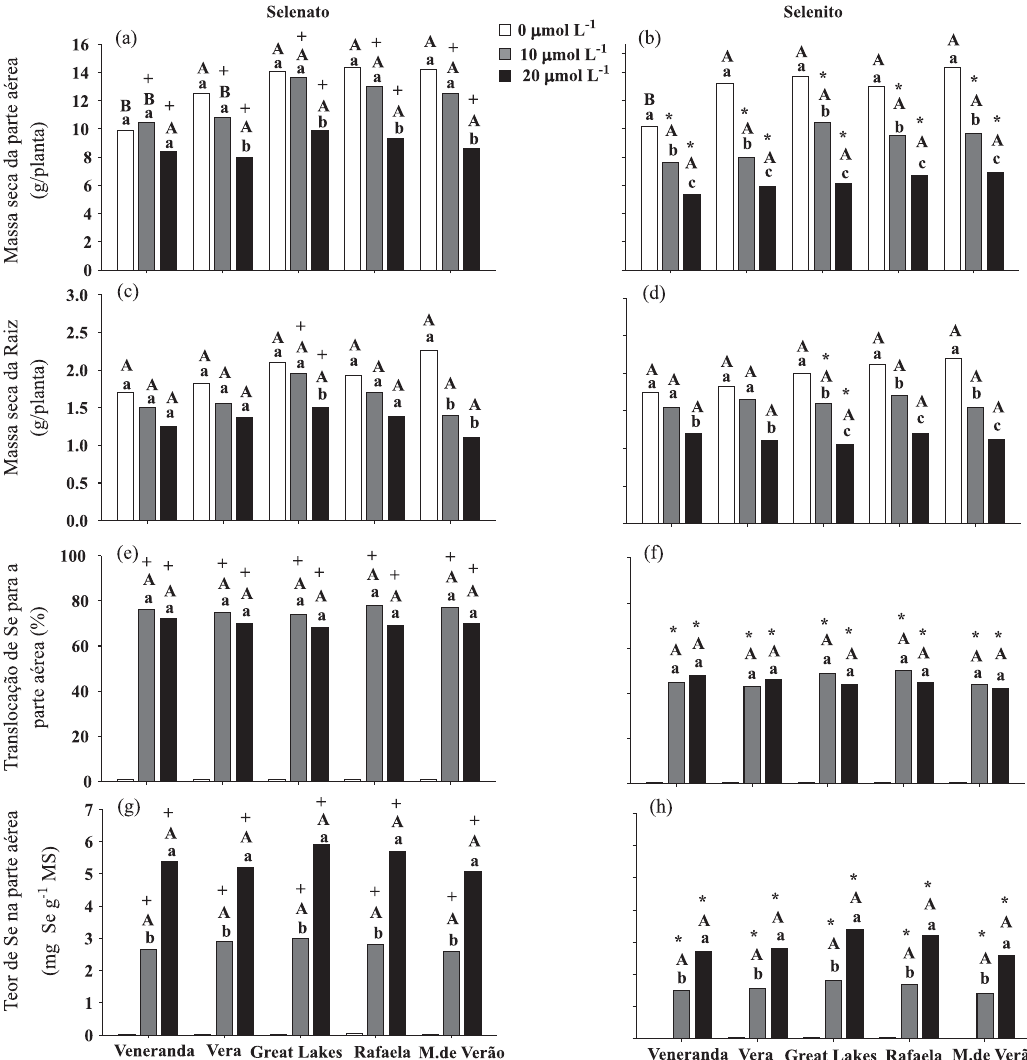
Figura 1. Massa seca da parte aérea (a, b), da raiz (c, d), translocação de Se para a parte aérea (e, f) e teor de Se na parte aérea (g, h) de cultivares de alface em função da aplicação de diferentes concentrações e formas de Se. Médias seguidas de mesma letra minúscula, comparando concentrações de Se dentro de cada cultivar, e maiúscula, comparando as cultivares em cada concentração e forma de Se, não diferem entre si (Scott-Knott, p ≤≤≤≤≤ 0,05). Médias seguidas por símbolos diferentes (+ e *), comparando as formas de Se (selenato e selenito) dentro de cada concentração de Se e cultivar, diferem entre si (Scott-Knott, p ≤≤≤≤≤